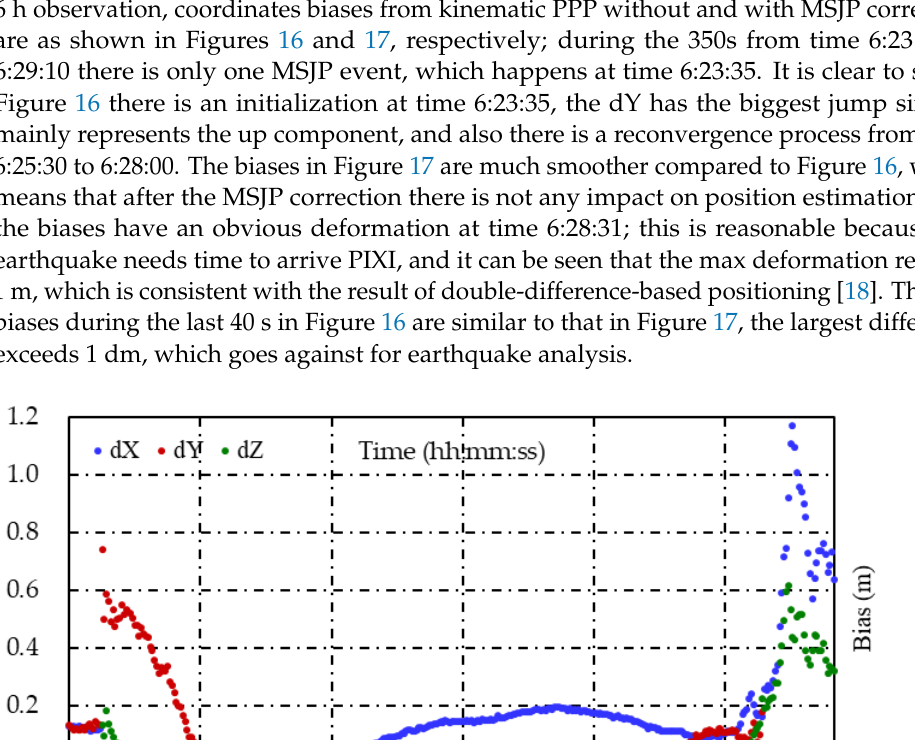
Figure 15. Original MW arc of G02 for site PIXI on 12 May 2008.